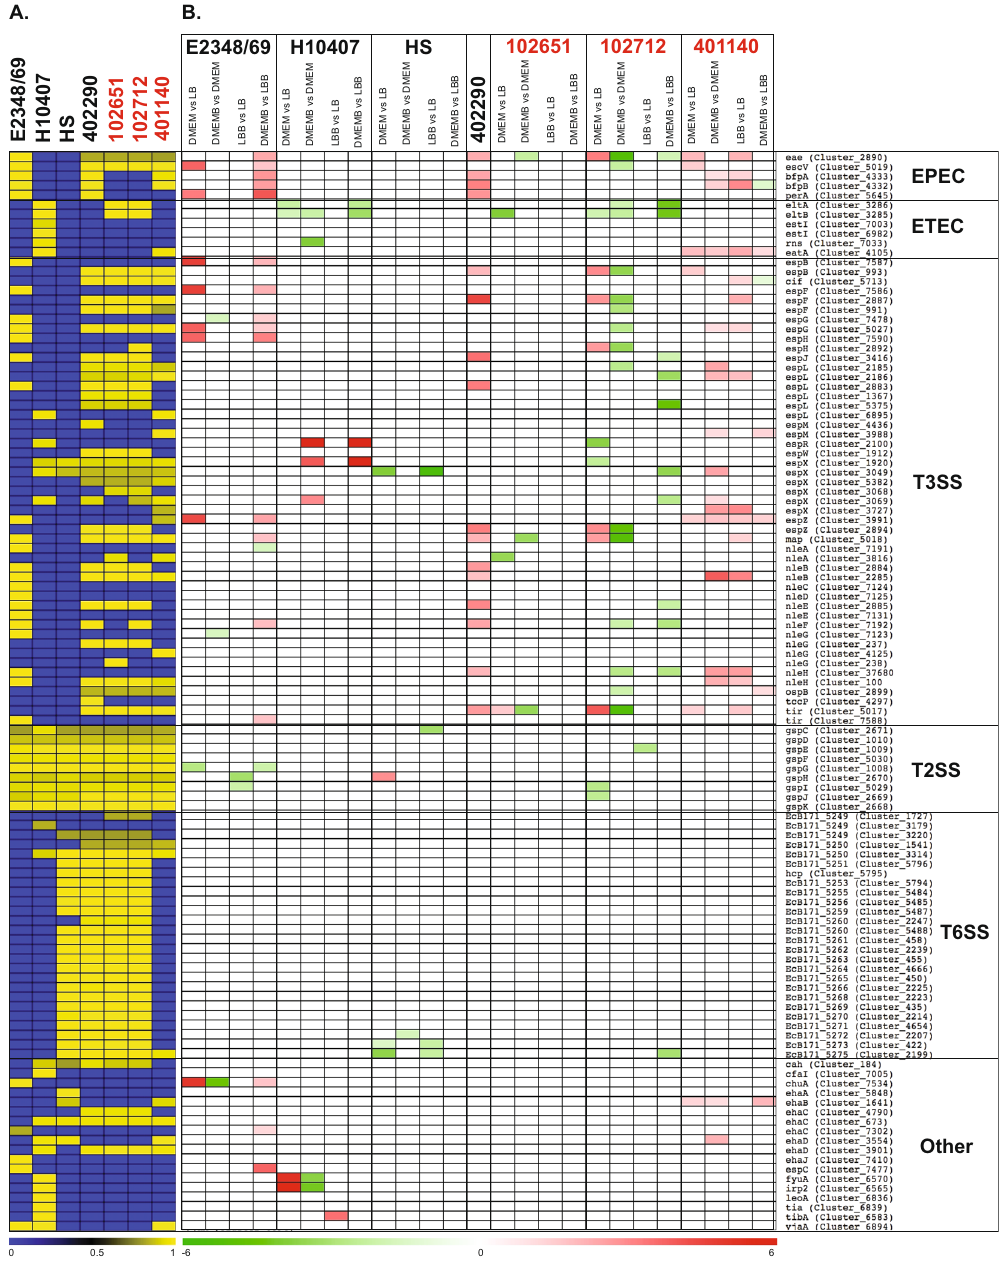
Figure 6. Differential expression of E. coli virulence genes. ( A ) In silico detection of E. coli virulence genes in each of the E. coli genomes analyzed in this study using RNA-Seq. The colors of the heatmap represent the BSR values of each gene with yellow indicating a gene is present and blue indicating a gene is absent. ( B ) Heatmap of the differential expression of the virulence genes for each of the sample comparisons of the E. coli isolates. Only significant log 2 fold-change (LFC) values ≥ 1 or ≤− 1 are represented in the heatmap. Red indicates increased differential expression while green indicates decreased differential expression. White indicates that a gene was either not present in the E. coli isolate, and/or did not exhibit significant differential expression. The only sample comparison of EPEC isolate 402290 that is shown is for DMEM compared to LB since this isolate was analyzed previously and was not grown with added bile salts (Hazen et al .